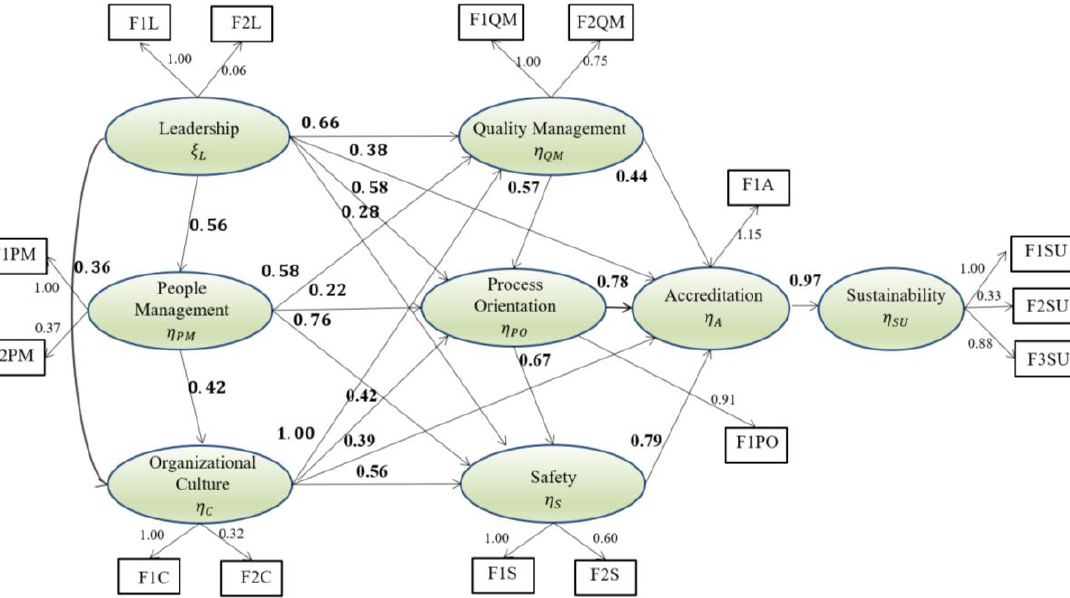
Table 4. Covariance matrix for the latent variables.